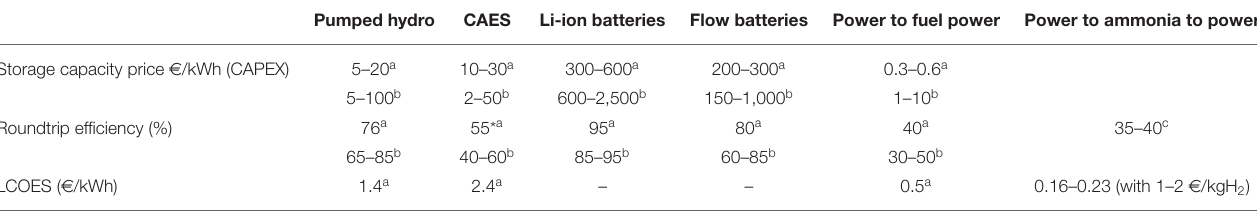
TABLE 1 | Comparison of storage technologies according to the global efficiency, CAPEX and LCOES—based on a Hedegaard and Meibom (2012) and Jülch (2016), b Gallo et al. (2016), c Elishav et al. (2017). Pumped hydro